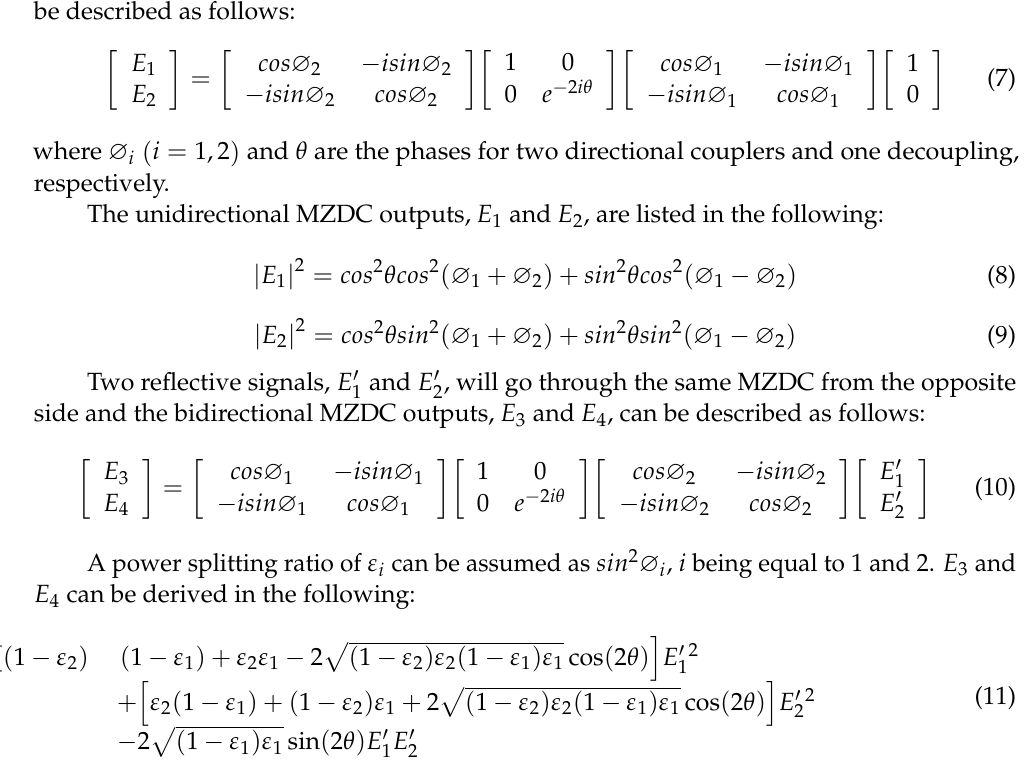
(PSF) response, a signal-reflection OCT response. Results indicate that a MZDC with a